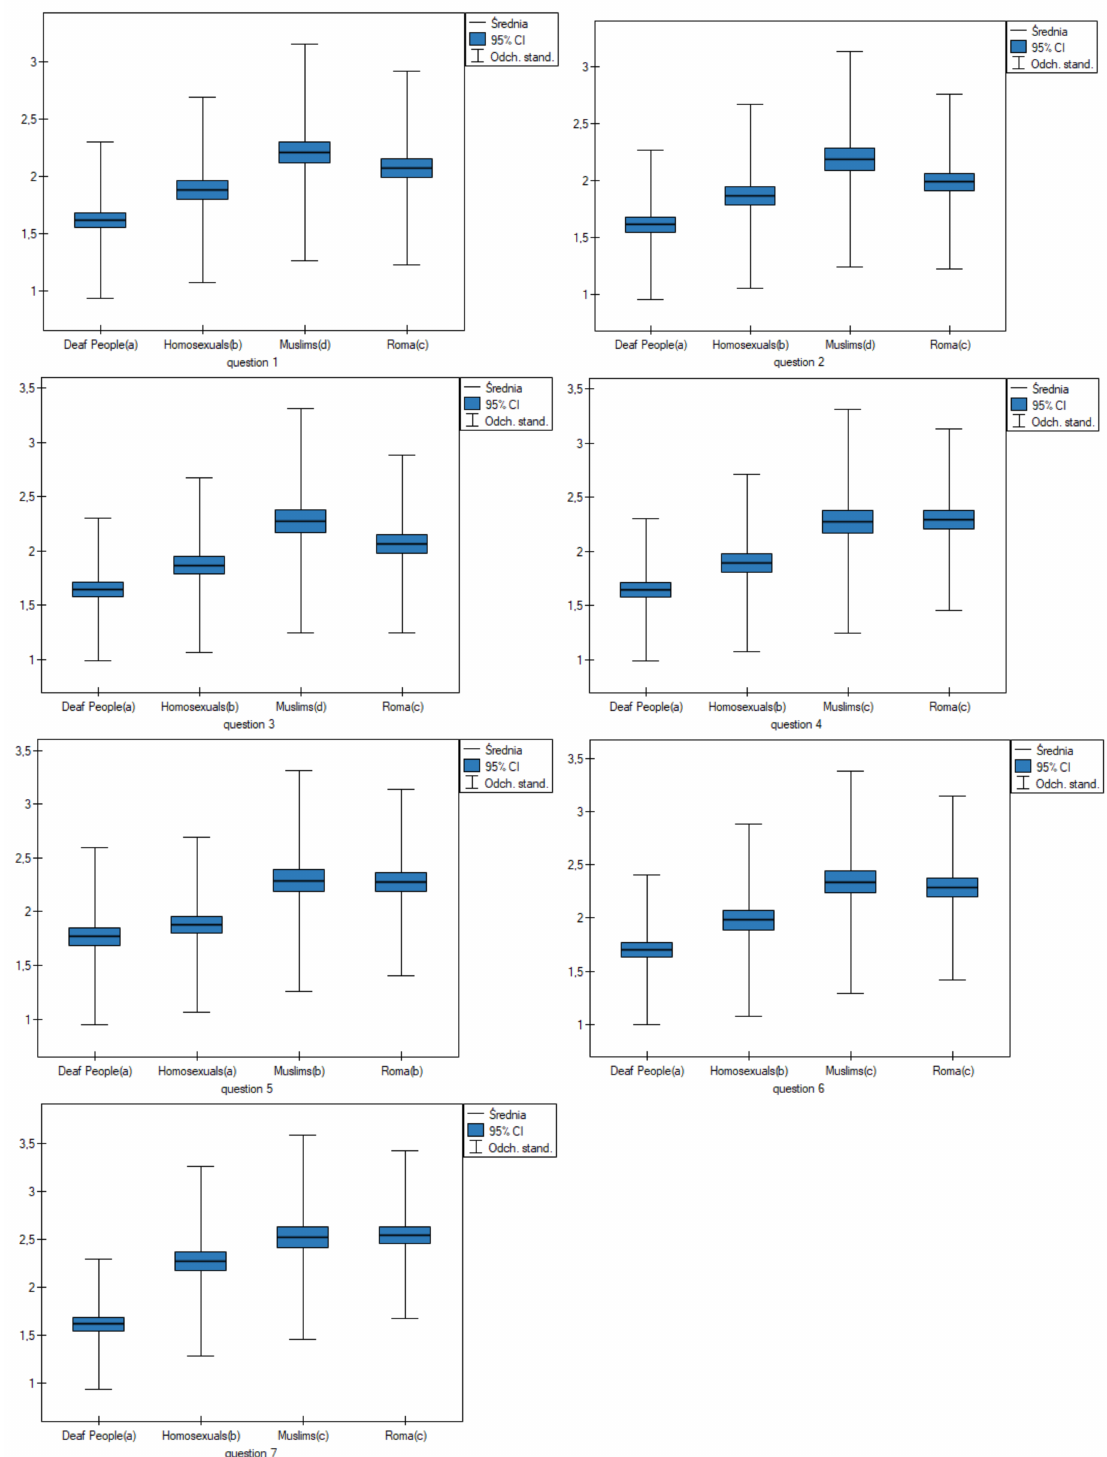
Figure 2. Observed variation in results between